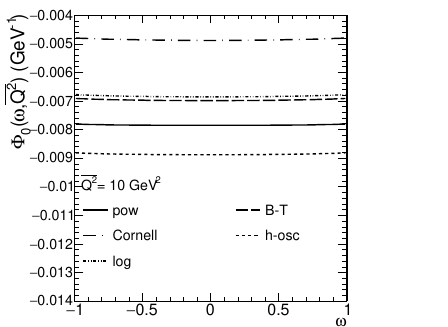
and F in the ( Q 2 , Q 2 ) -plane. The form factor F TT LT 1 2 = Q 2 line, while F has no symmetry properties. LT 1 2